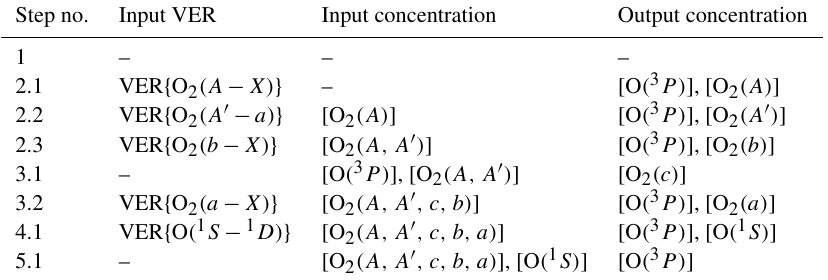
Table 12. Overview of the calculation steps carried out using the MAC model. The first column shows the step number. The input concen- trations shown in the third column were retrieved at one of the previous steps and are required together with profiles of input VER and the other MAC input parameters at the current retrieval step. The other MAC input parameters should be at least comprised of temperature ( T ), O 2 and N 2 that can be simulated using the NRLMSISE-00 model. If only these MAC input parameters are available, then the prior step 1 described in Sect. A1 is omitted. Nevertheless, if [ O 3 ] and [ H ] were also available among the other MAC input parameters, then [ O ( 1 S) ] , [ O ( 1 D) ] , [ OH ∗ ] and [ HO ] would be calculated at the prior step 1 and also used as MAC input parameters at the following steps. 2 Step